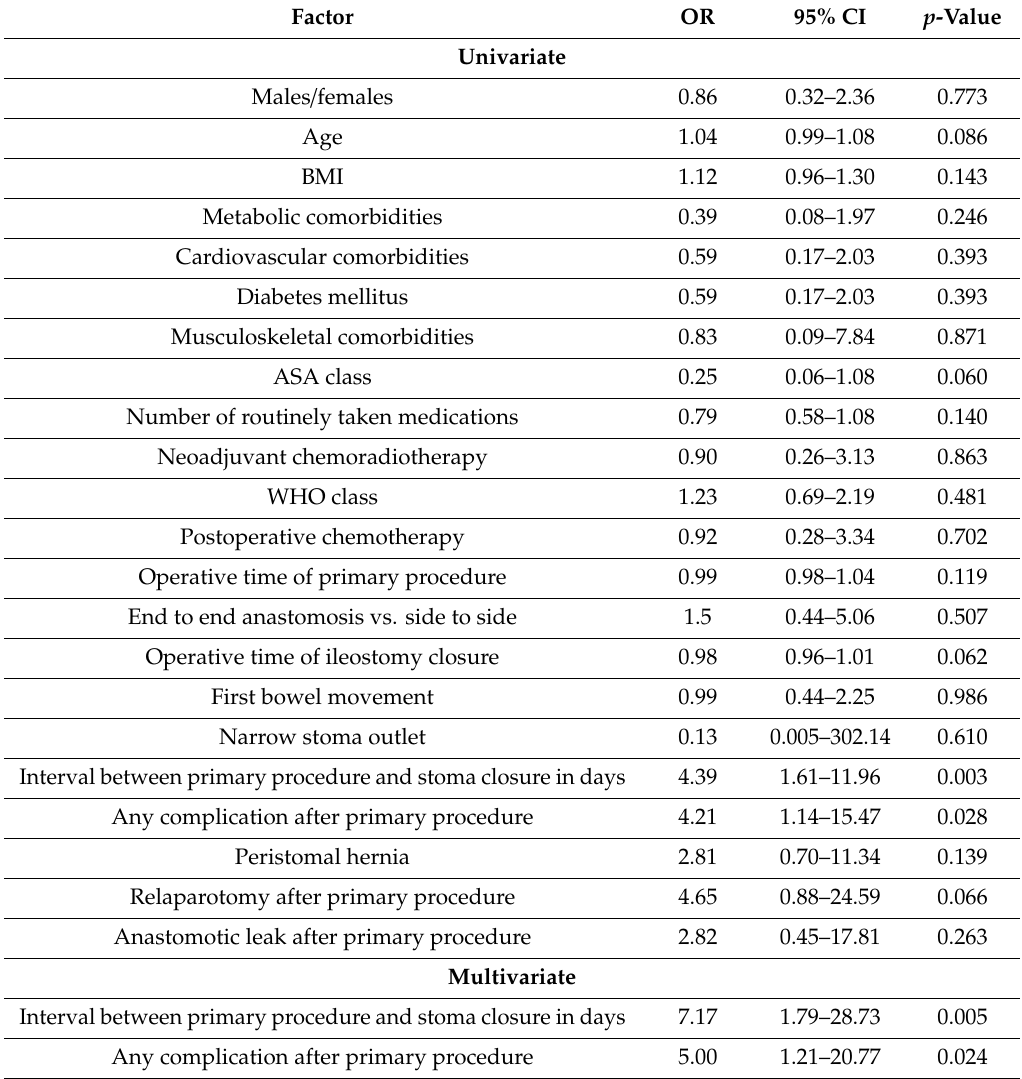
Table 4. Univariate and multivariate logistic regression models analyzing factors potentially influencing perioperative complications of stoma